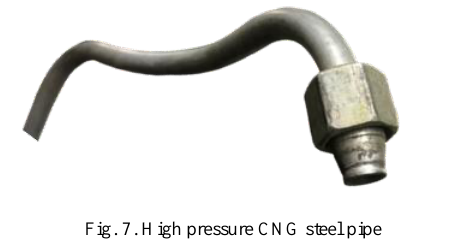
Fig. 7. High pressure CNG steel pipe